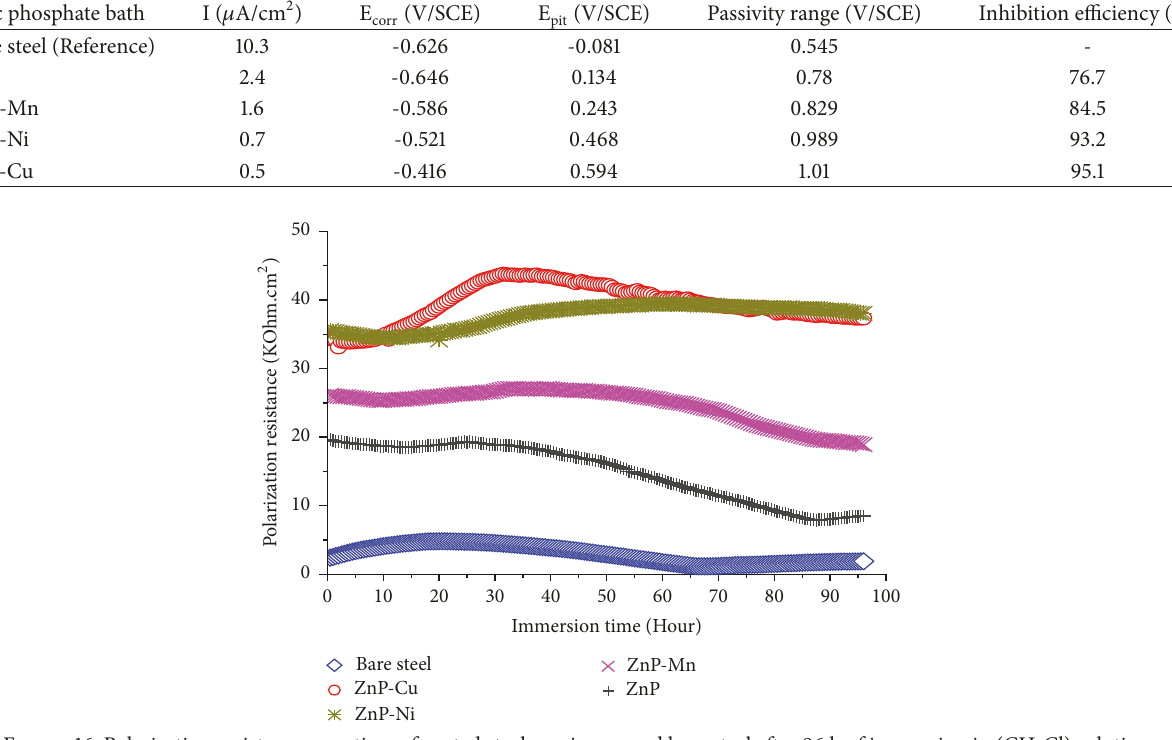
Figure 16: Polarization resistance over time of coated steel specimens and bare steel after 96 h of immersion in (CH-Cl)